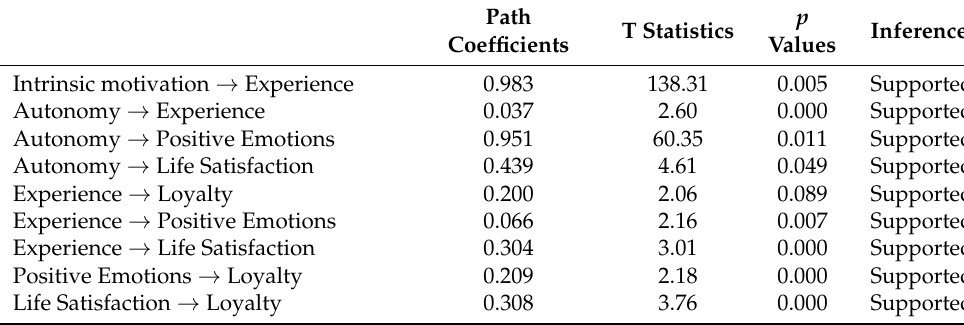
Table 5. Hypothesis testing